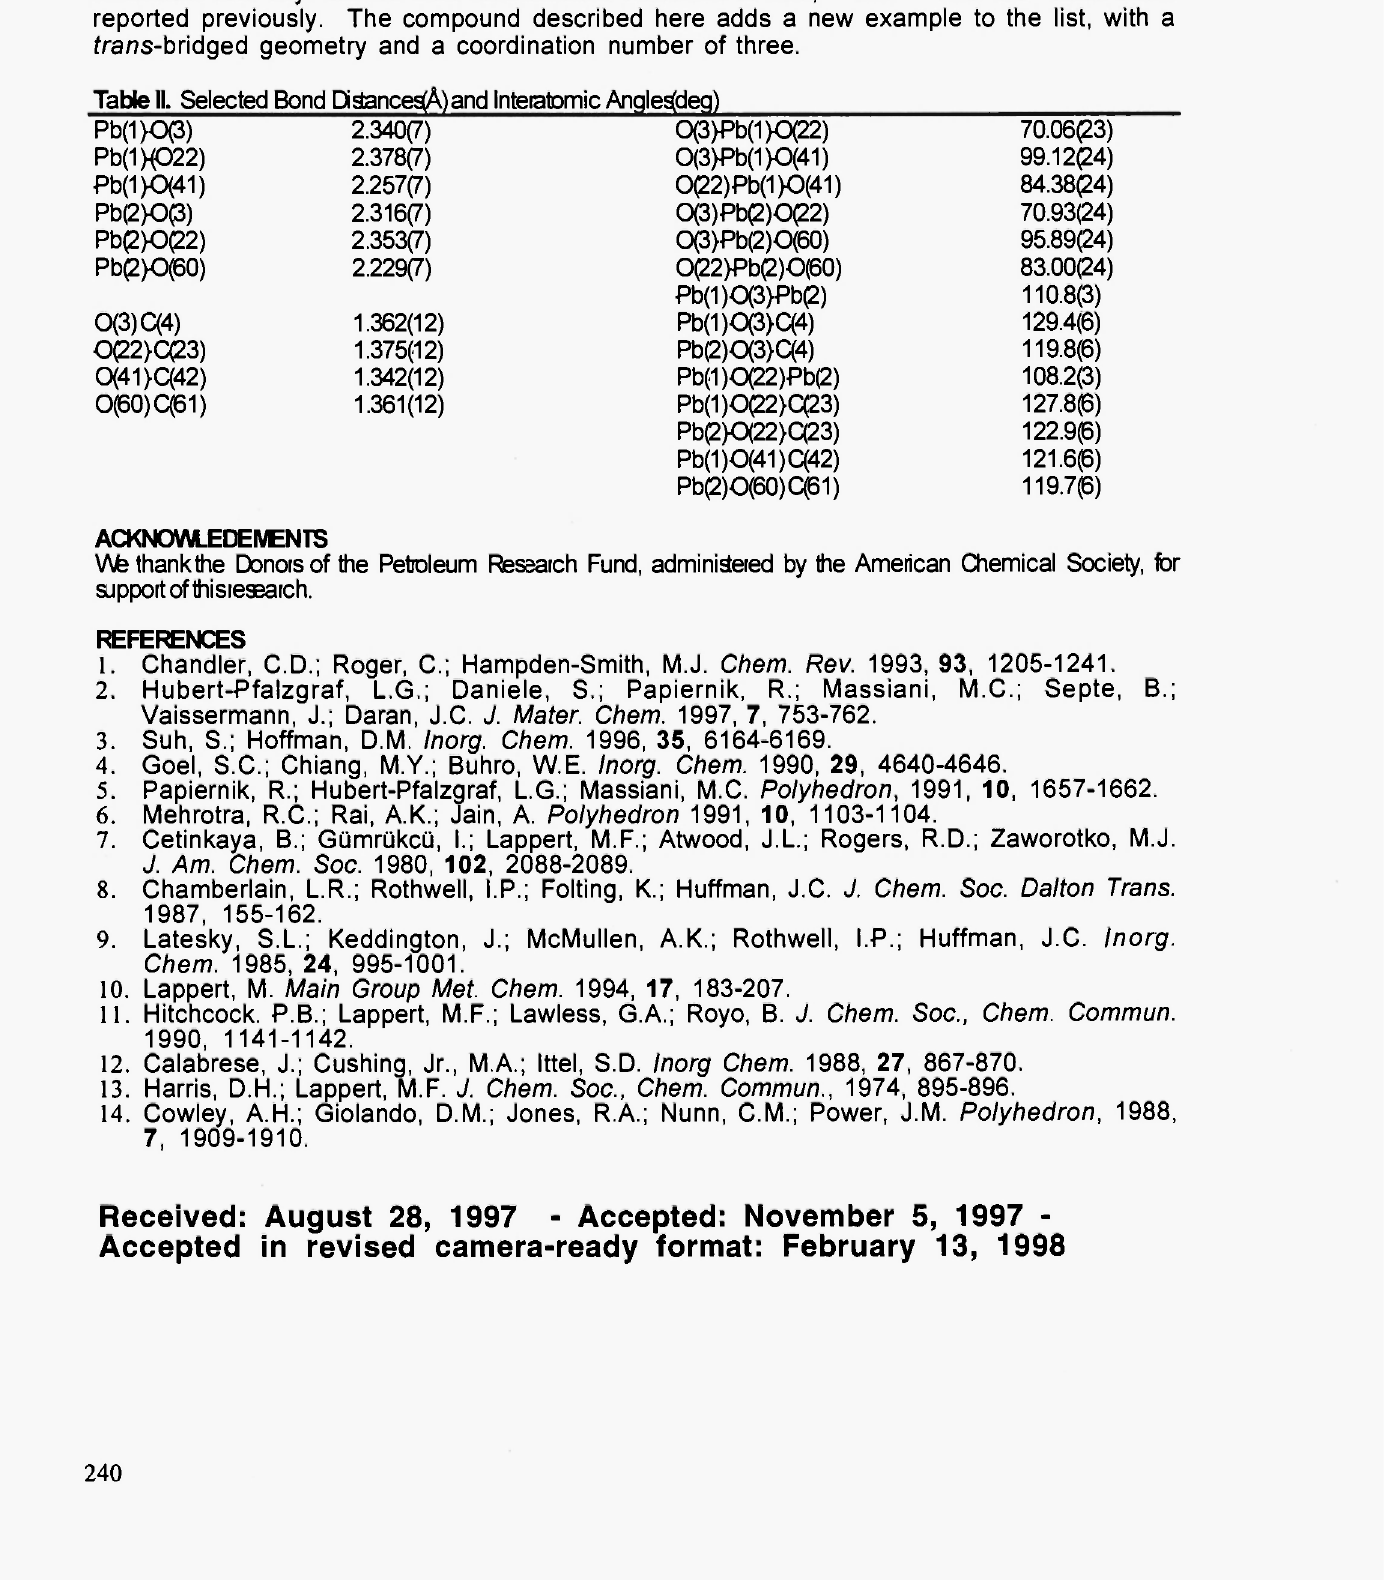
Table II. Selected Bond Distances(A)and Interatomic